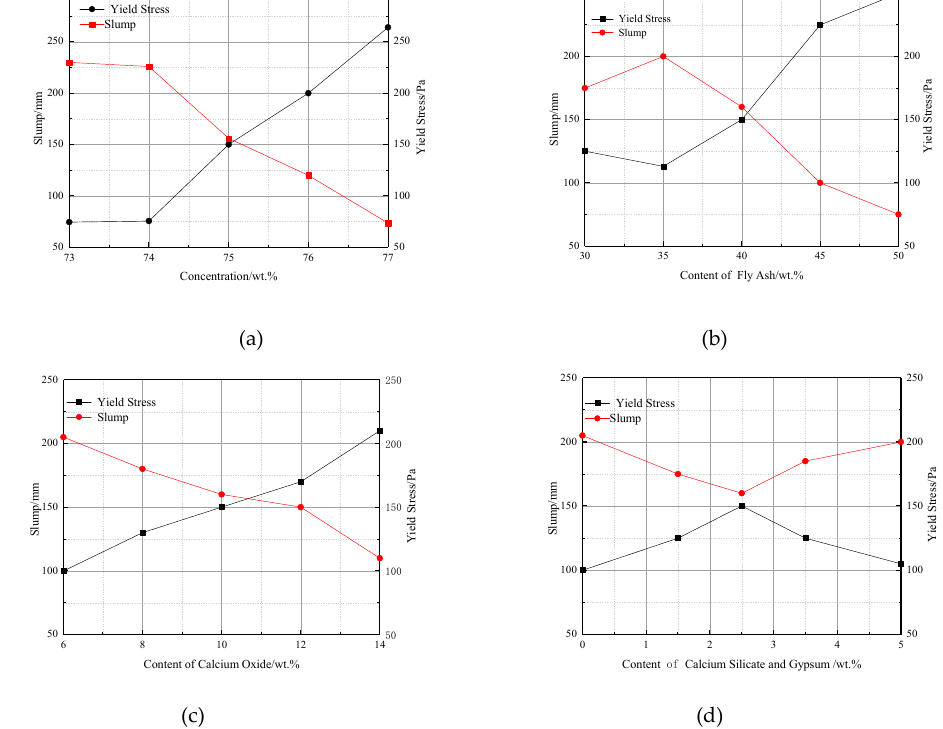
Figure 7. Slump and yield stress data for cemented backfill materials. ( a ) Influence of concentration; ( b ) Influence of content of fly ash; ( c ) Influence of concentration of calcium oxide; and ( d ) Influence of concentrations of calcium silicate and gypsum.